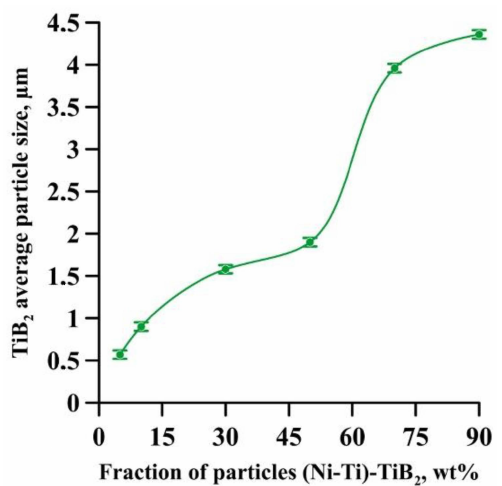
Figure 12. Graph of the average size of TiB 2 particles in the Inconel 625–NiTi–TiB 2 composite